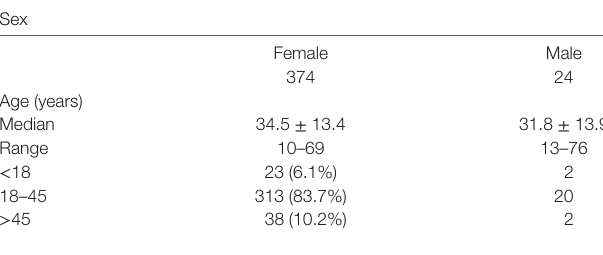
TaBle 1 | The demographics of systemic lupus erythematosus